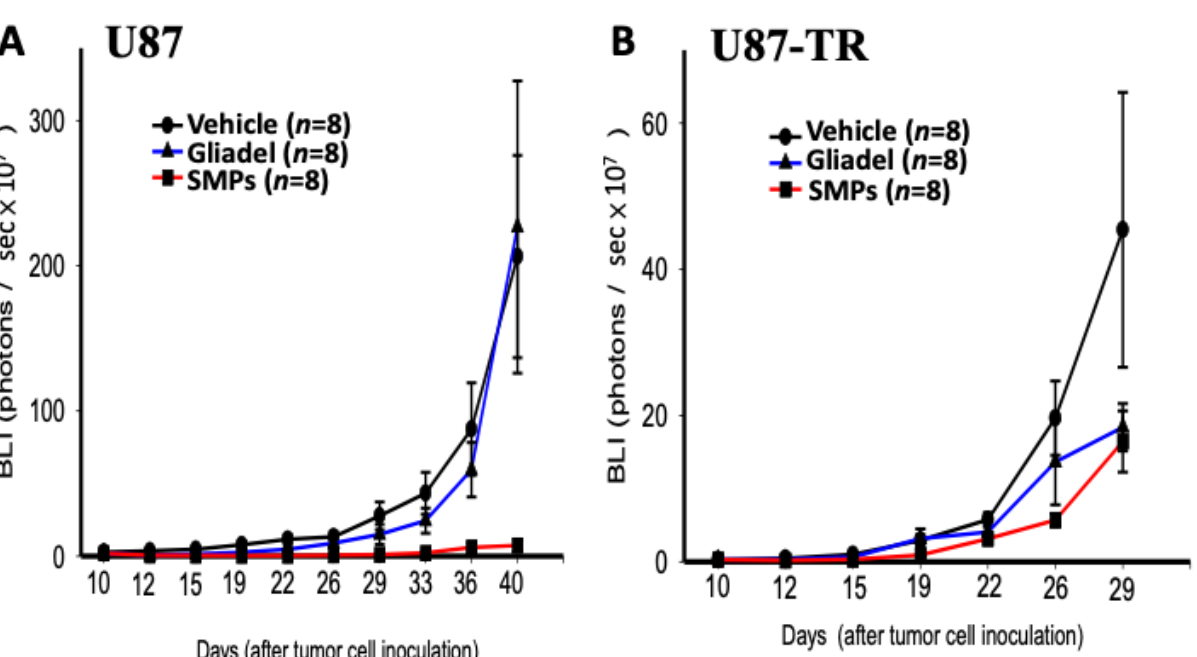
Figure 3. Quantification of average tumor bioluminescence values throughout the course of treatment with TMZ vehicle, TMZ-combined Gliadel, and TMZ-combined SMPs. ( A ) Mice bearing U87 xenografts. The bioluminescent intensity of tumors was significantly lower in the mice treated with TMZ-combined SMP treatment since day 12 compared to TMZ vehicle treatment ( p = 0.0015); TMZ-combined SMP treatment since day 19 compared to TMZ-combined Gliadel treatment ( p = 0.038); TMZ-combined Gliadel treatment since day 19 compared to TMZ vehicle treatment ( p = 0.0145). Comparison of the inhibition of tumor growth following different treatments during the period of 10–40 days, the bioluminescent intensity of tumors was significantly lower in the mice treated with TMZ-combined SMP treatment compared to TMZ vehicle treatment ( p < 0.001); TMZ-combined SMP treatment compared to TMZ-combined Gliadel treatment ( p = 0.0017); TMZ-combined Gliadel treatment compared to TMZ vehicle treatment ( p = 0.0143). ( B ) U87-TR xenografts. The bioluminescent intensity of tumors was significantly lower in the mice treated with TMZ-combined SMP treatment since day 12 compared to TMZ vehicle treatment ( p = 0.0015); TMZ-combined SMP treatment since day 19 compared to TMZ-combined Gliadel treatment ( p = 0.0183); TMZ-combined Gliadel treatment since day 12 compared to TMZ vehicle treatment ( p = 0.0362). Comparison of the inhibition of tumor growth following different treatments during the period of 10–26 days, the bioluminescent intensity of tumors was significantly lower in the mice treated with TMZ-combined SMP treatment compared to TMZ vehicle treatment ( p < 0.001); TMZ-combined SMP treatment compared to TMZ-combined Gliadel treatment ( p = 0.00363); TMZ-combined Gliadel treatment compared to TMZ vehicle treatment ( p < 0.001). The study was powered with eight mice per treatment cohort for statistical significance. Log-rank (Mantel–Cox) tests were performed on survival plots. A Student t -test was used to quantify differences in treatment arms.